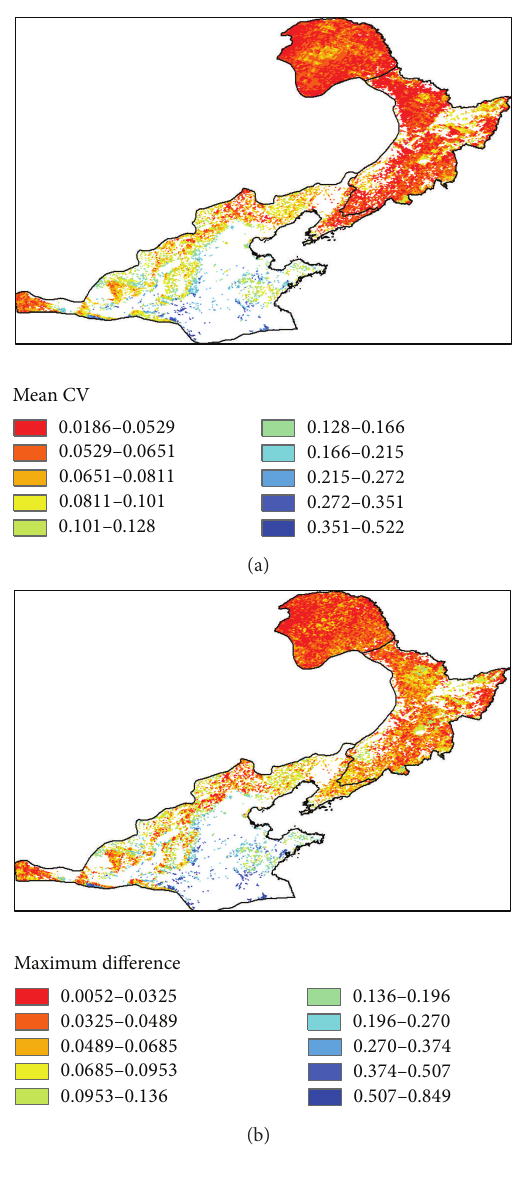
Figure 4: (a) The coefficient of variation (CV) of satellite-derived SOS measures (1982–2006) averaged from the results of the five methodsand(b)maximumdifferenceamongtheCVoffivesatellite- derived SOS measures.